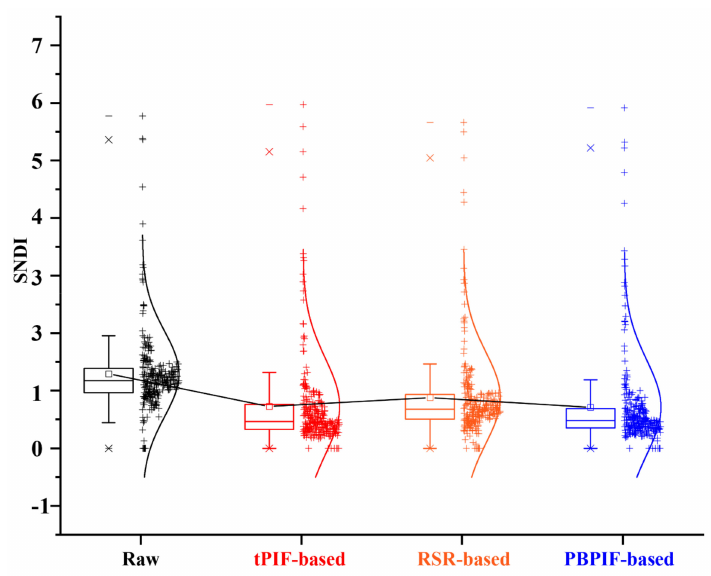
Figure 8. Comparison of global SDNI between raw NTL and corrected NTL.